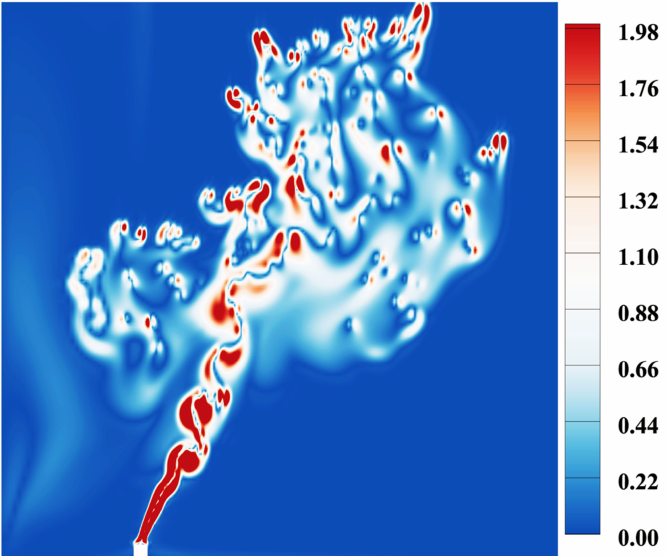
Figure 7. Contour plots of vorticity field influenced by ocean currents. ( U 0 = 0.15 m/s, U P = 0.15